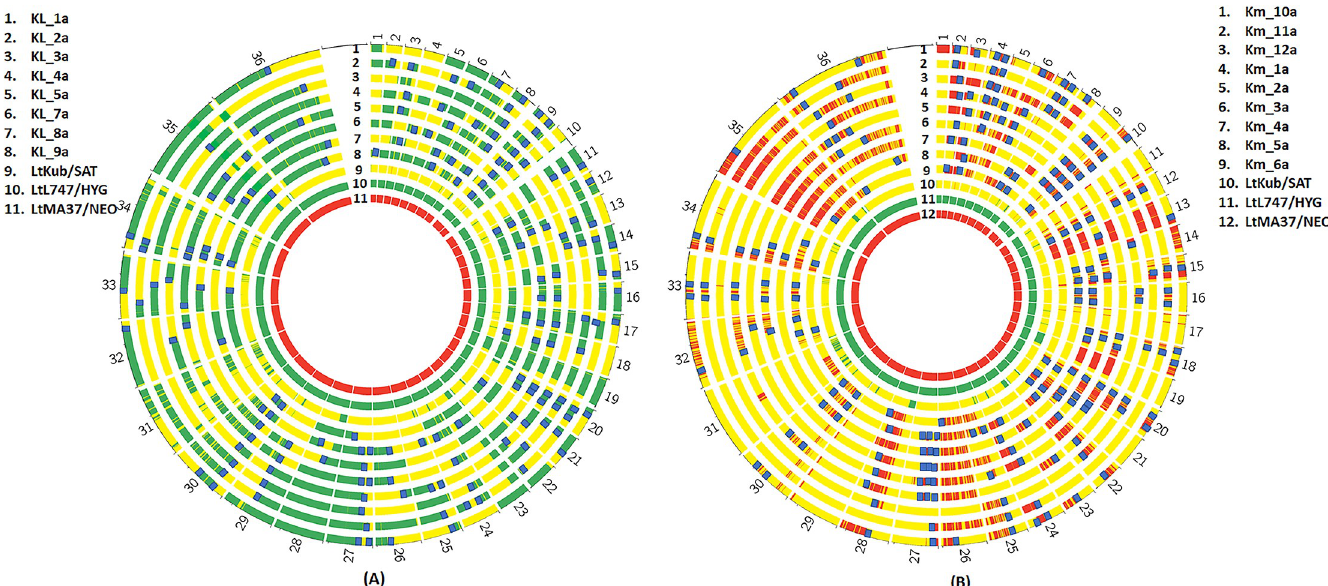
Fig 5. Allele composition maps reveal recombination breakpoints in L . tropica hybrids. A total of 32923 biallelic markers with homozygous differences between LtMA37/NEO and LtL747/HYG were followed. The marker position was colored as red if both alleles matched LtMA37/NEO, as green if they both matched LtL747/ HYG, and as yellow if heterozygous. LtKub/SAT is 99% heterozygous for these markers, indicating that it is a hybrid between lines that share ancestry with LtL747 and LtMA37. The profiles of the outcrosses of LtKub/SAT with LtL747/HYG (left plot) or with LtMA37/NEO (right plot) indicate regions that alternate between homozygosity and heterozygosity, similar to backcrosses. The recombination break points are indicated by the blue bars.